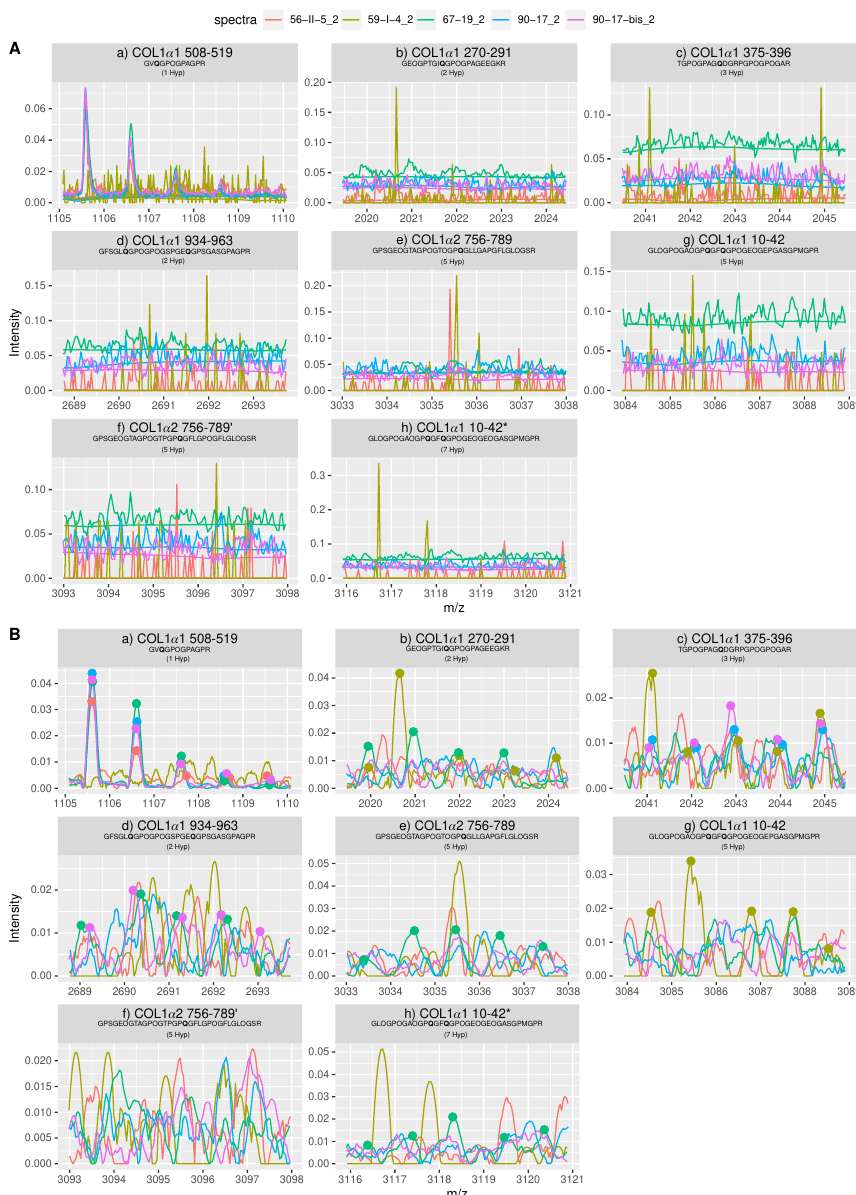
Figure 1. Illustration of overlapping isotopic distribution (up to 6 peaks) of deamidated and non-deamidated fraction of peptides used in the model before (A), and after preprocessing (B). We show the baseline estimated on the smoothened spectra and the peaks that are detected after the preprocessing step 3). Note the variation in intensity and the difference in the S/N of peaks for each peptide. Whereas there is a clear distinction of individual peaks (hence, high S/N) for COL1 ↵ 1 508-519, peak distinction becomes complex for COL1 ↵ 1 10-42 or COL1 ↵ 2 756-789 due to the noisy spectra (hence, less S/N). Five randomly selected samples are shown here.